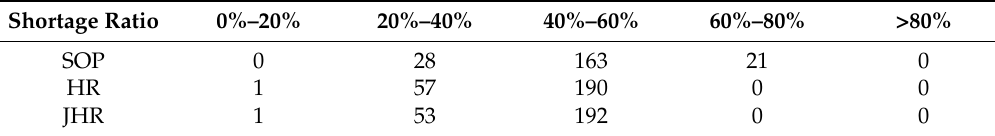
Table 8. Number of different water shortage in ( xd , xd )